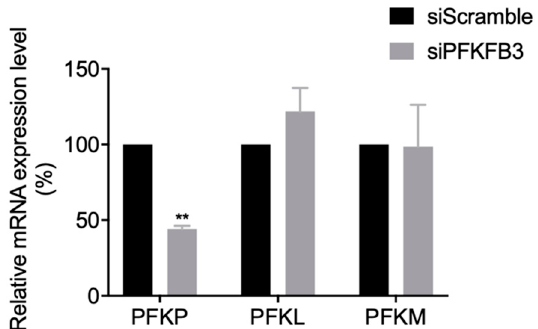
Figure 5. PFKP is responsible for the reduced PFKFB3 expression suppressing EV-A71 replication. The mRNA expression of the three PFK isoform genes (PFKP, PFKL, and PFKM) were analyzed by qRT-PCR after 100 nM siPFKFB3 or siScramble was transfected into rhabdomyosarcoma (RD) cells for 24 h. ** denotes p < 0.01 by Student’s t -test. The results are shown as the mean ± SEM.